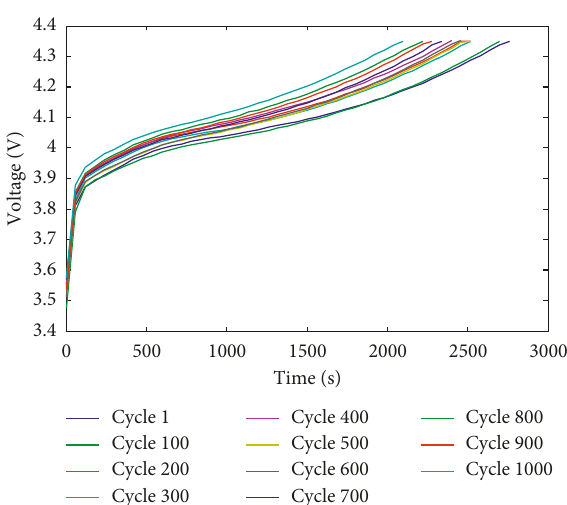
Figure 1: Constant current charge curves of a battery with different aging